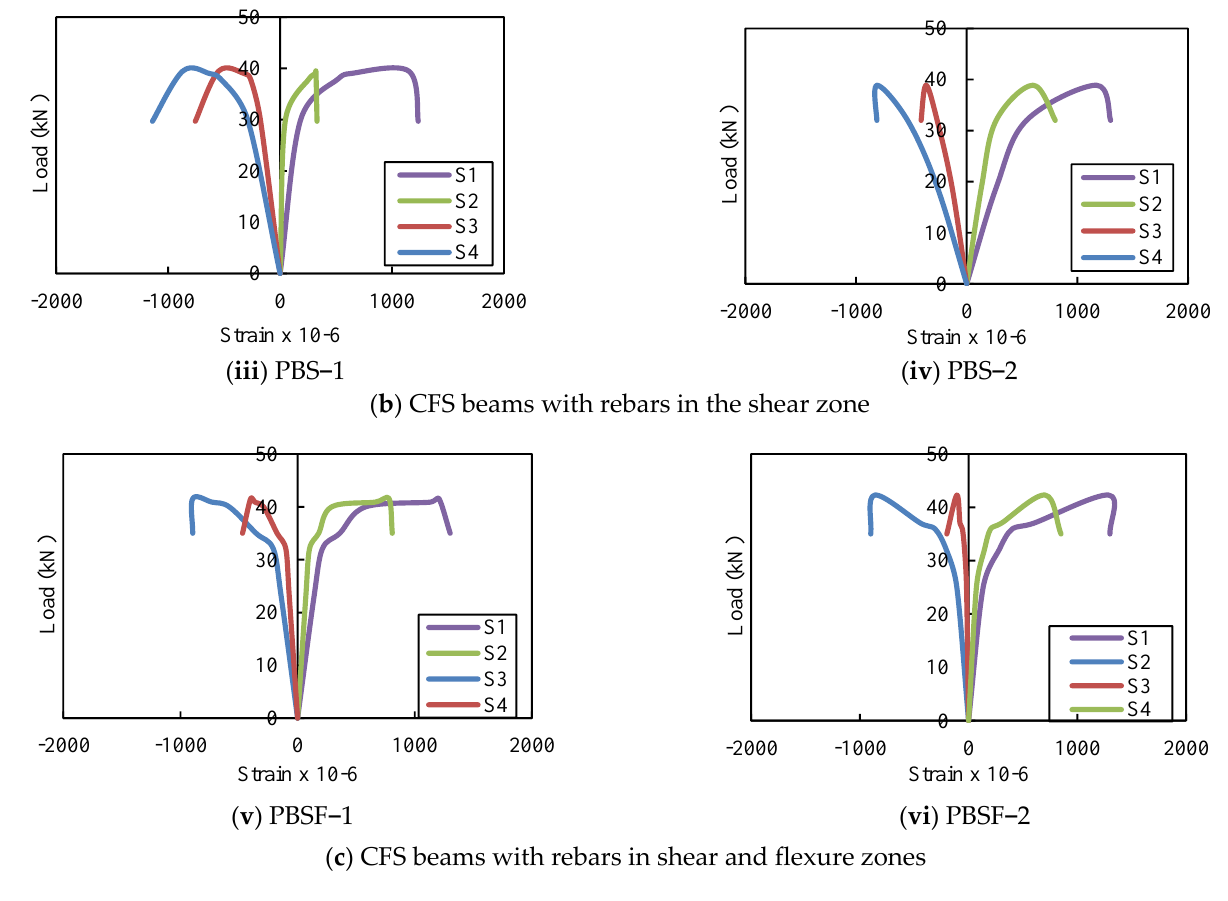
Figure 10. Load versus strain curves for plain CFS beams. Figure 11 depicts the load – strain behaviour of composite CFS beams. The average compressive strain on the upper flange of composite CFS beams with no rebars in the web (CB), rebars in the shear zone of the web (CBS), and rebars in the shear and flexure zones of the web (CBSF) was 0.03%, and the upper flange began to buckle. Maximum loads applied on average were 82 kN, 88 kN, and 90 kN, respectively. The corresponding ultimate strains and loads were 967 με , 1074 με , and 1319 με , respectively, and 106, 110, and 114 kN.